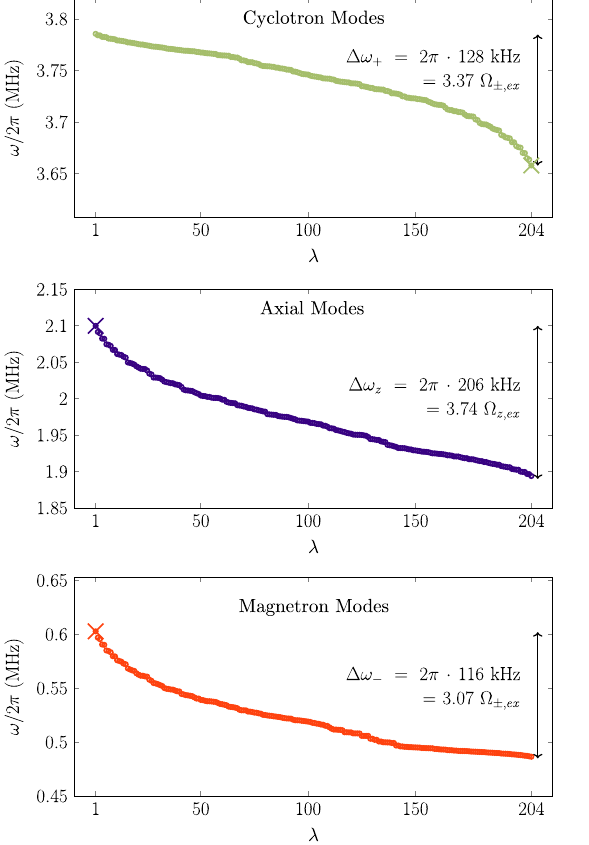
FIG. 6. Frequency spectrum of a 204-ion honeycomb lattice (nearest-neighbor distance d ¼ 15 μ m) arranged with the tilted configuration ( Θ ¼ 20 °). Shown here are the cyclotron, axial, and magnetron branches of the normal modes. The center-of-mass frequency in each mode branch is marked with a cross. The width of each branch is shown in terms of the respective two-ion exchange frequency through black arrows.